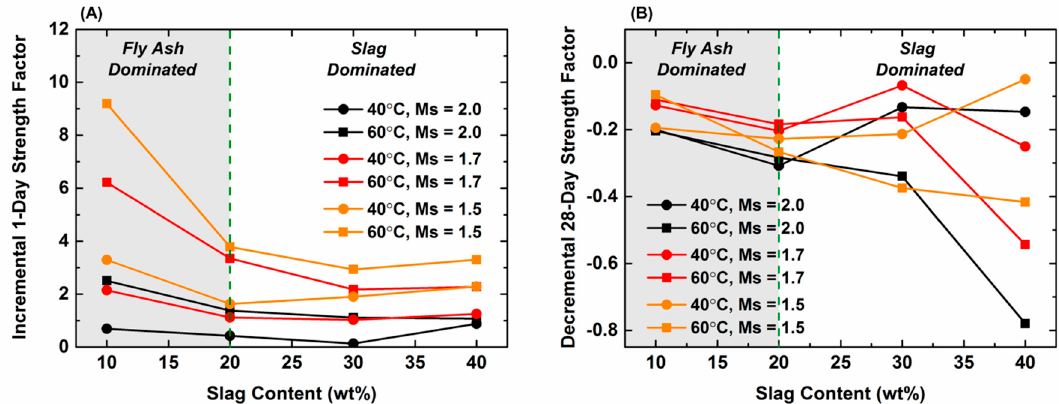
Figure 5. ( A ) Incremental strength factor (1-day compressive strength relative to that following curing at 25 ◦ C for 24 h) ( B ) Decremental strength factor (28-day compressive strength relative to that following curing at 25 ◦ C for 24 h) as a function of curing temperature, Ms value, and slag content.